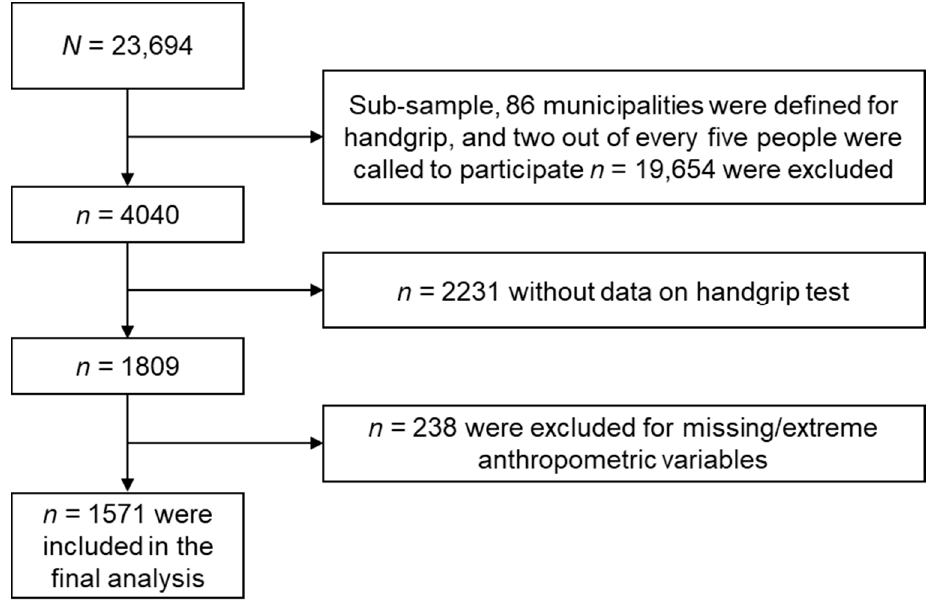
Figure 1. Flow chart showing the selection of the study sample from the Colombian Health and Wellbeing and Aging Survey (SABE) 2015. All analyses presented in this paper are based on 1571 surveyed participants, each with complete anthropometric, blood-based, and covariable data.